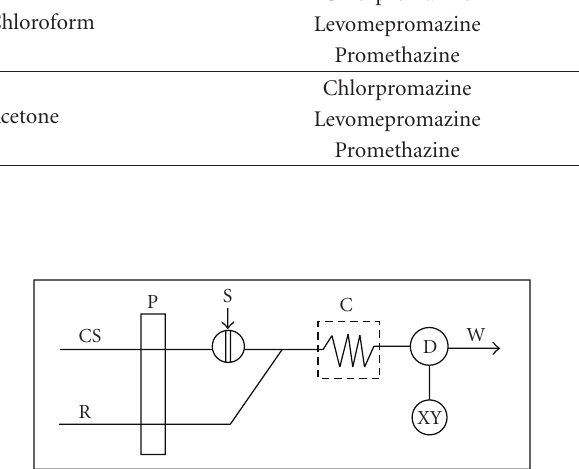
Table 5: Extractive-spectrophotometric and spectrophotometric methods of determination of some of 2,10-disubstituted phenothiazines. Organic phase